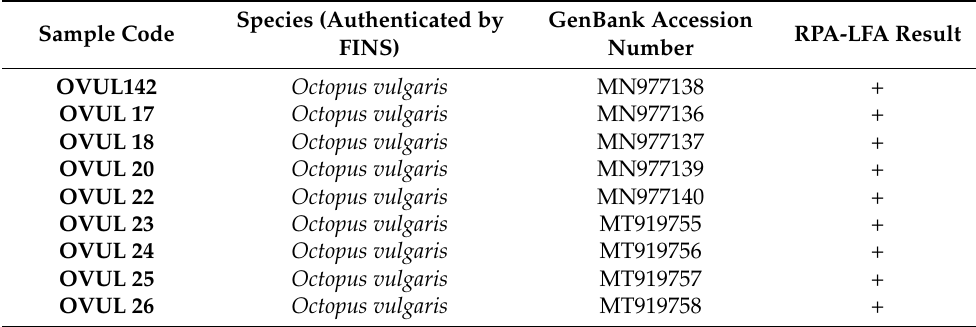
Table 1. List of the reference samples used in this study. The table shows the corresponding species authenticated by FINS, the GenBank Accession number for the COI sequence and the RPA-LFA test result of each sample ( n =